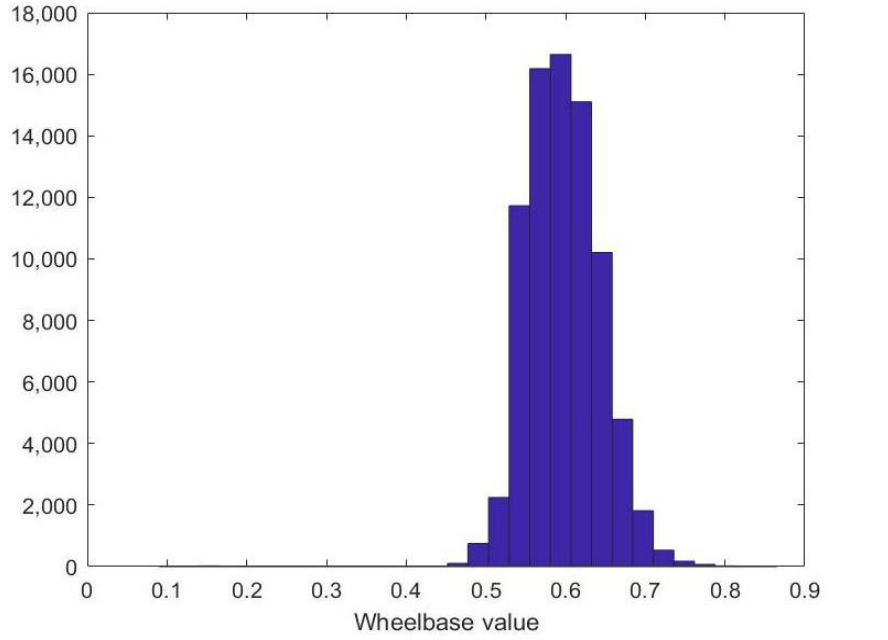
Figure 9. The distance between wheel-centers (wheelbase)